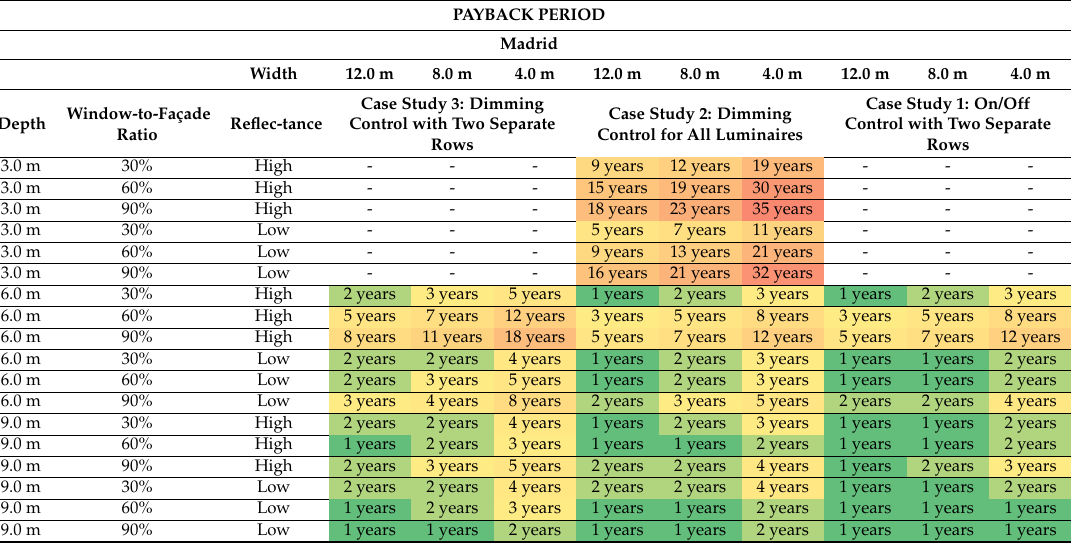
Table 16. Payback period according to different lighting smart controls in